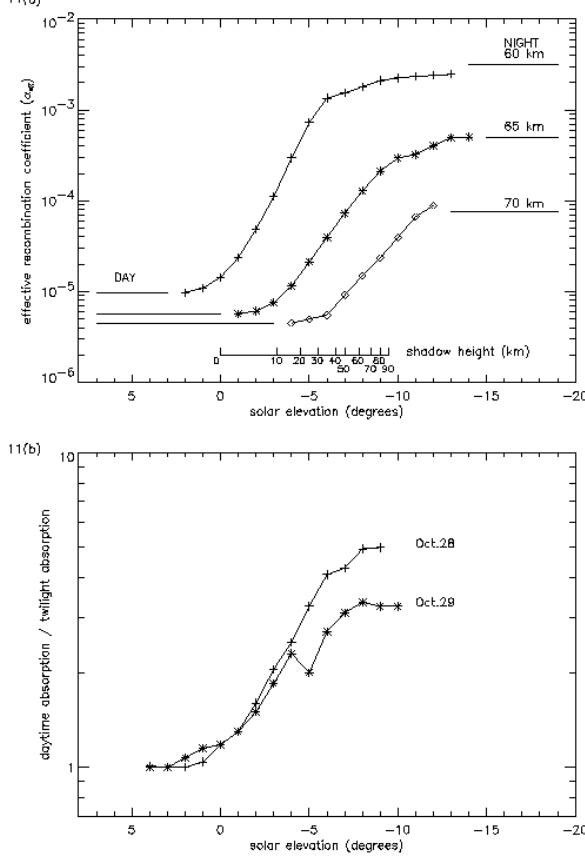
Fig. 11. Changes during evening twilight as a function of solar elevation. (a) Effective recombination coefficient (uncorrected) at 60, 65 and 70km, based on the observations of 28–29 October. The median day and night values have been added. (b) Change of 38 · 2MHz radio absorpion at Kilpisj¨arvi for 28–29 October sep- arately. Since the absorption reduces during twilight the plot shows the ratio (daytime value)/(twilight value). The values have been corrected for the computed variation of production rate at